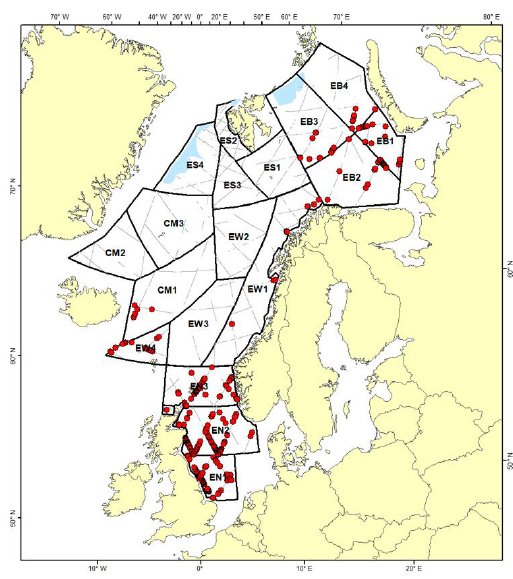
Figure 9. Distribution of northern bottlenose whales sighted during the 2014 – 2018 sighting surveys. The blue areas represent ice coverage.